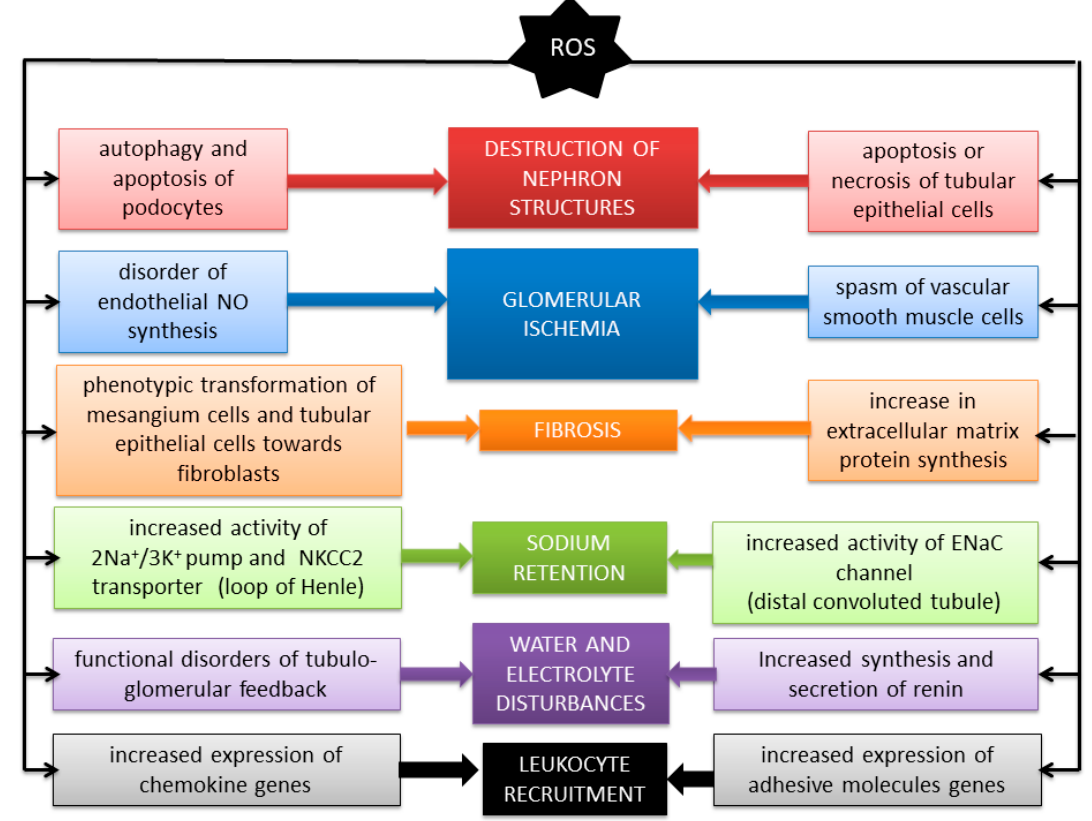
Figure 1. Impact of reactive oxygen species (ROS) on the kidneys.